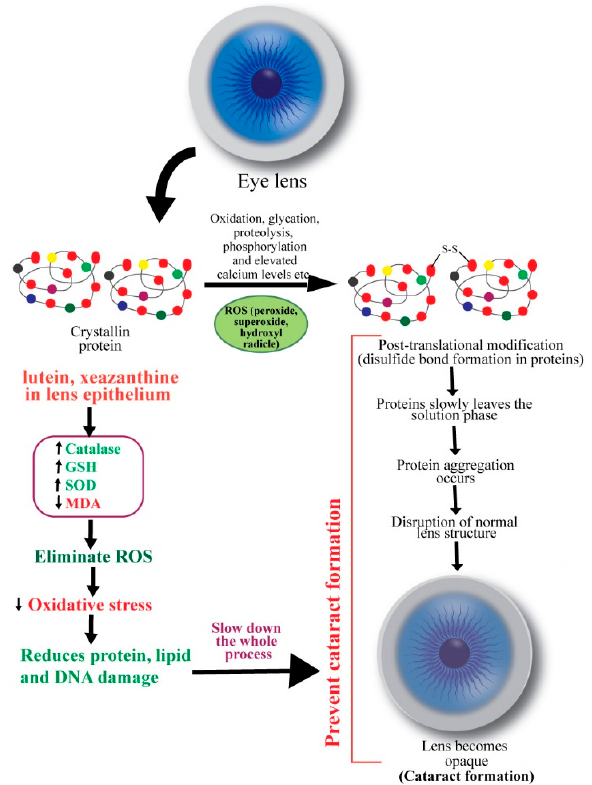
Figure 2. Schematic diagram showing the mechanisms of action of carotenoids to prevent cataract. ROS: reactive oxygen species.